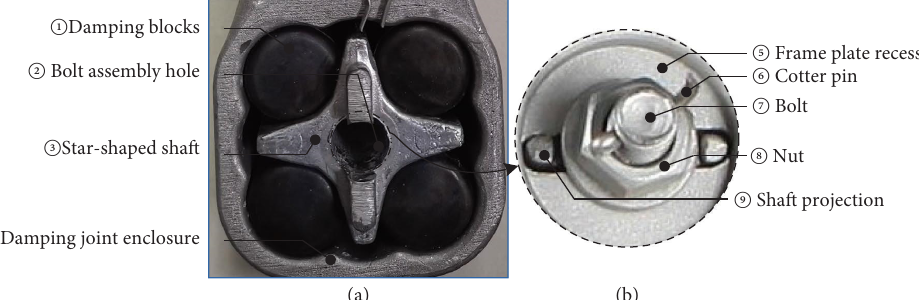
Figure 3: Damper joint structure of the regular spacer damper: (a) damper joint component composition and (b) structure composition of damper joint fxation part.